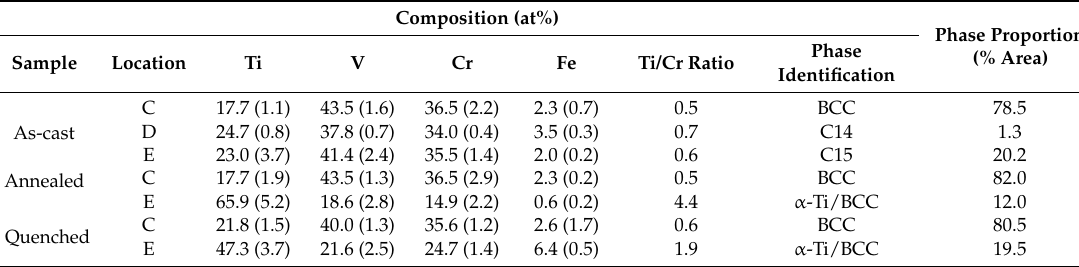
Table 2. EDS results of the as-cast and heat-treated Ti 34 V 40 Cr 24 Fe 2 .